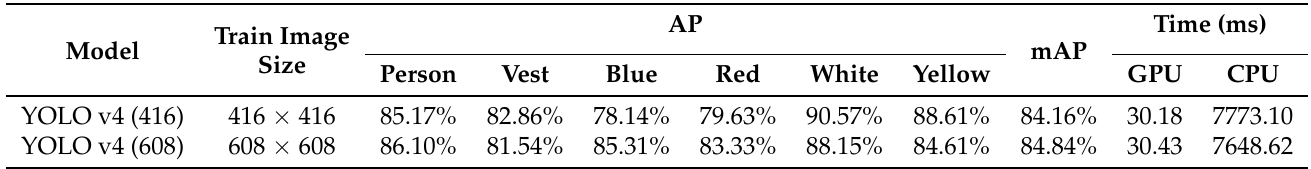
Table 5. Performance of YOLO v4